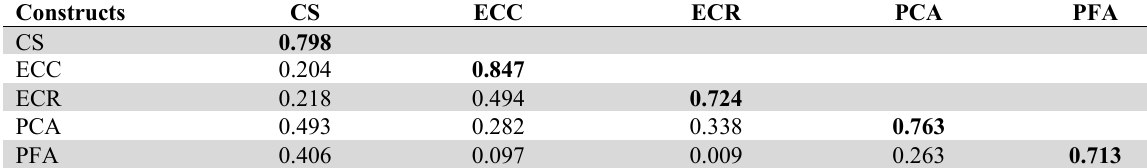
Fornell-Larcker Discriminant Validity Criteria (AVE-SV Comparison) Constructs